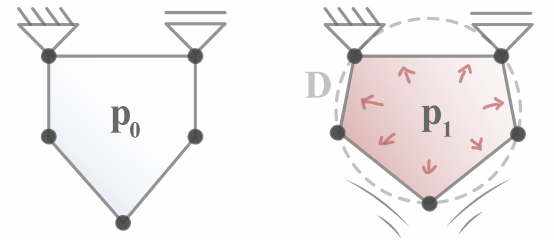
Figure 2. Shape change of a pentagonal cell by pressure-induced volume increase. Reprinted/adapted by permission from Springer Nature